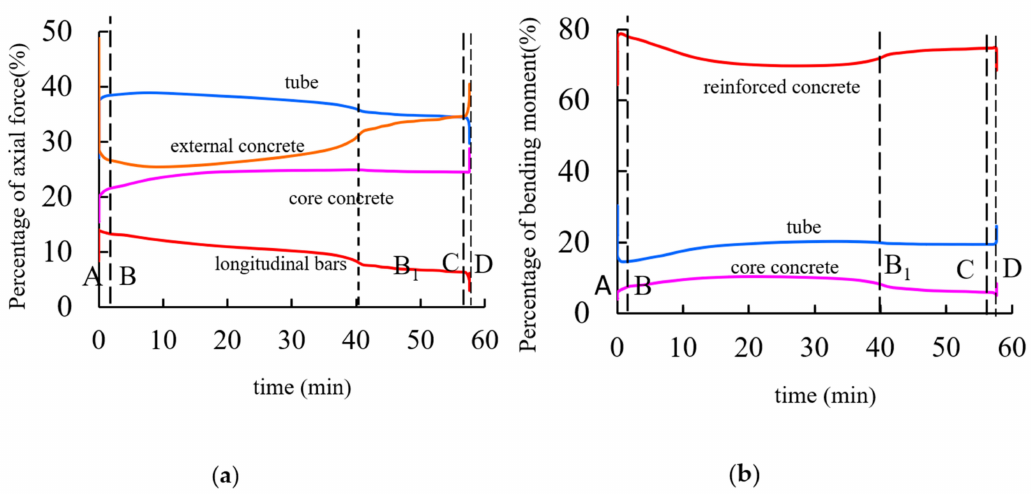
Figure 10. Percentage of internal force ( a ) Axial force ratio curve; ( b ) Moment ratio